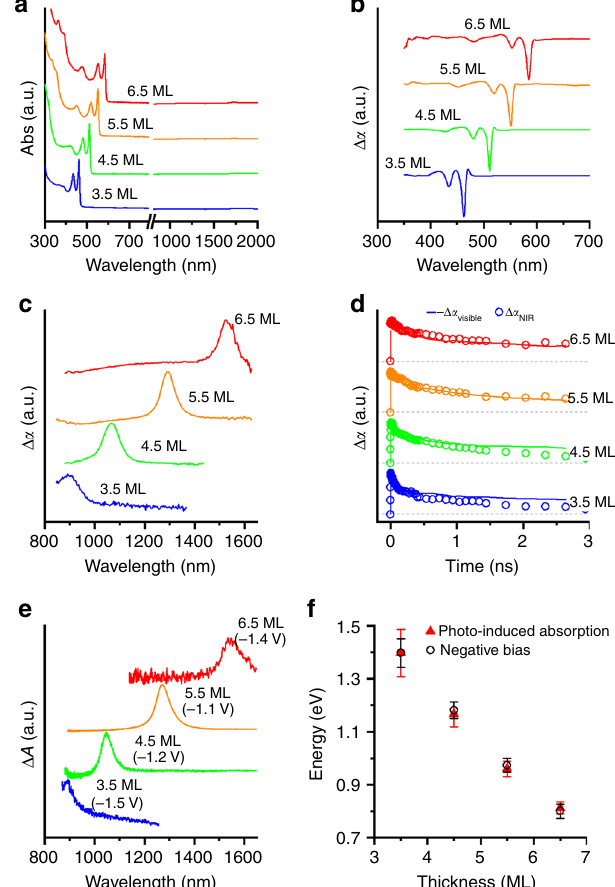
Fig. 1 Thickness-dependent static and time-resolved optical properties of CQWs. a The 295 K static absorption spectra covering visible and NIR energies of CdSe CQW ensembles with atomically de fi ned thicknesses, as labeled in the panel. Data were collected in two separate measurements for the visible and NIR (merged at 800 nm). b Visible- and c NIR-probe transient absorption spectra of the same samples with 400nm excitation at 10 ps delay. d Transient absorption dynamics of the fi rst excitonic bleach feature (shown as solid lines) and the NIR-induced absorption feature (shown as open circles) for each of the samples at comparable fl uence. e Static change in absorption spectra ( Δ A ) of electrochemically pumped CQW samples under applied bias (vs. SCE listed on the plot) in an electrolyte. f Fitted energy of the photoinduced (closed red triangles) and electrochemically induced (open black circles) NIR absorption feature vs. the thickness (in monolayers of CdSe units). The error bars represent the full-width at half-maximum of the